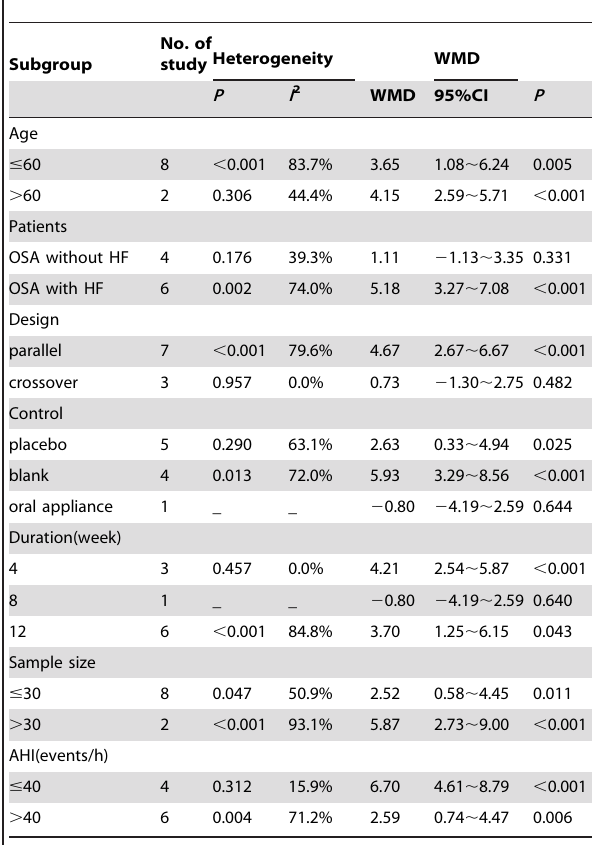
Table 3. The results of meta-regression. Table 4. The results of subgroup